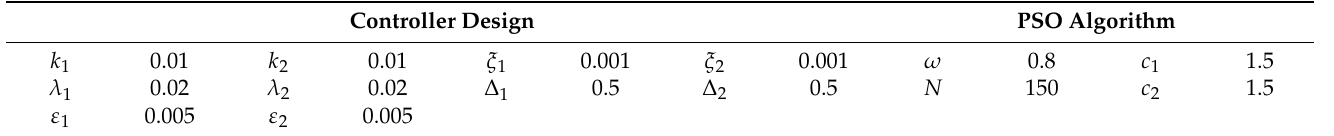
Table 2. Parameters of the optimization